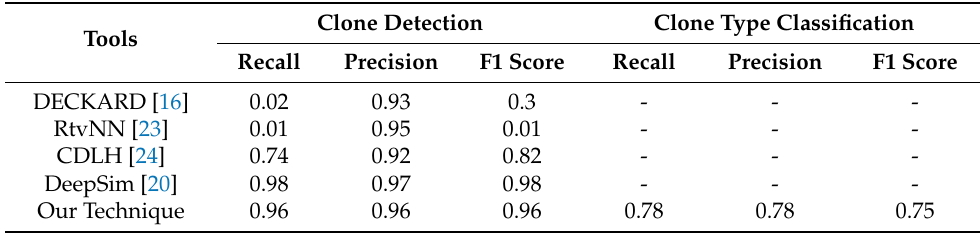
Table 6. Comparison results of existing tools and our technique.